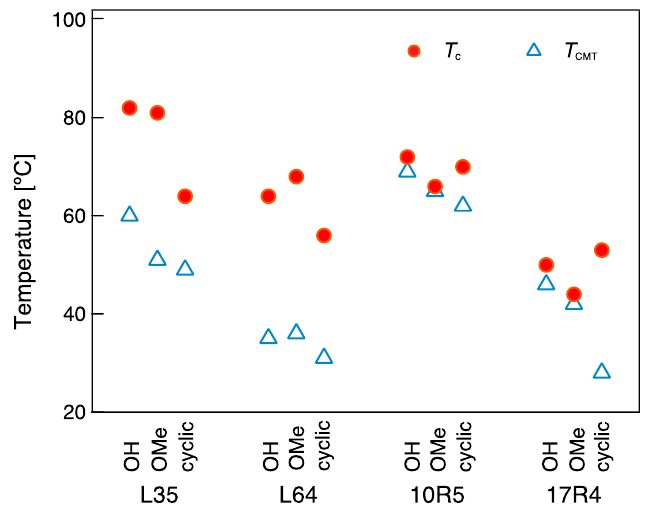
Figure 6. Critical micellization temperature ( T CMT ) and cloud point ( T c ) for 10 g/L solutions of Pluronic L35, L64, 10R5 and 17R4. Linear hydroxy-terminated species, linear methoxy-terminated and cyclized species are represented as OH , OMe , and cyclic , respectively.